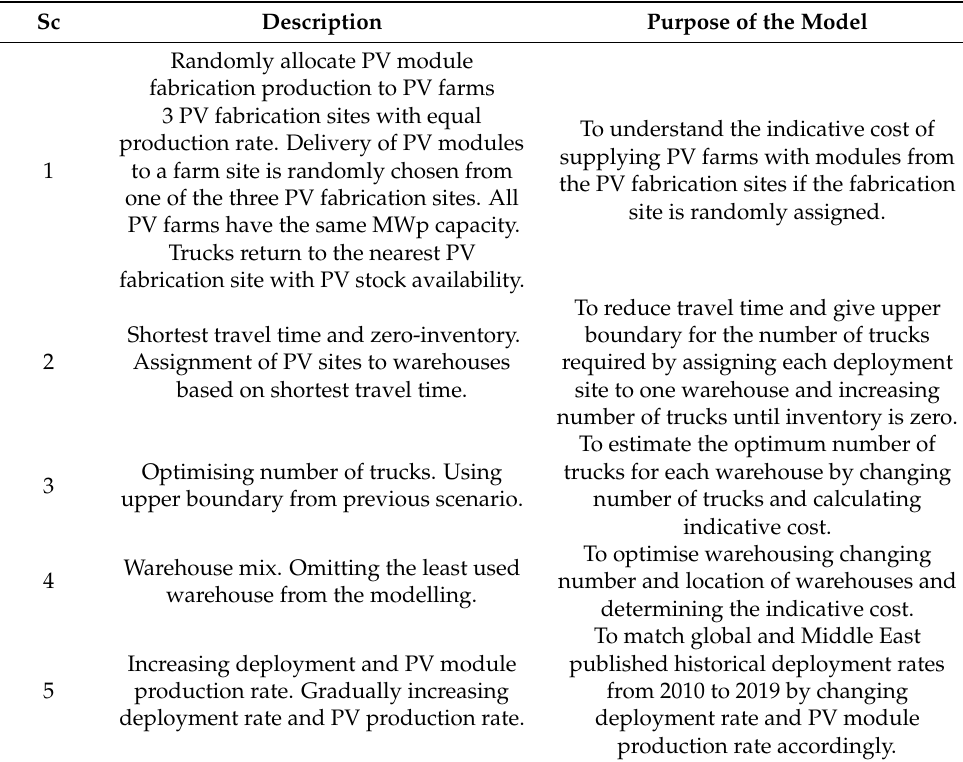
Table 3. Simulation scenarios for Saudi Arabia PV